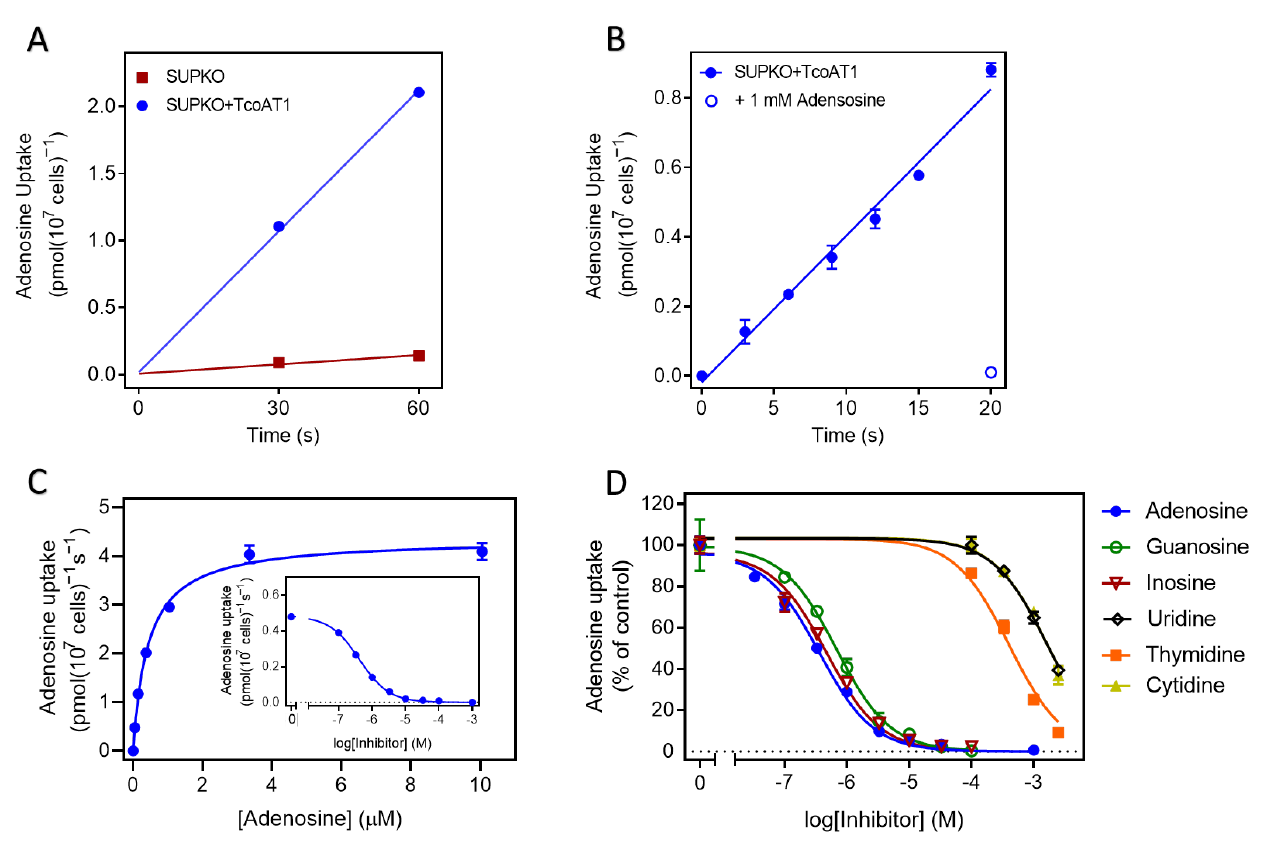
Figure 3. Uptake of 0.05 µ M [ 3 H]-adenosine in L. mexicana SUPKO expressing TcoAT1. ( A ) Uptake in L. mexicana SUPKO and SUPKO+TcoAT1 over 60 s. The expression of TcoAT1 restored adenosine uptake in SUPKO. Data represent averages ± SEM of triplicate determinations. ( B ) Uptake of [ 3 H]-adenosine in L. mexicana SUPKO+TcoAT1 within linear phase of 20 s. ( C ) Adenosine uptake by SUPKO+TcoAT1 in the presence of 0–1 mM unlabeled adenosine. Graph shows one representative out of three independent experiments carried out in triplicate all showing a similar result. ( D ). Substrate specificity of TcoAT1 determined by uptake assays. TcoAT1 has high affinity for both amino- and oxopurines. Inhibition constants (K i ) for purines were lower than those of pyrimidines.